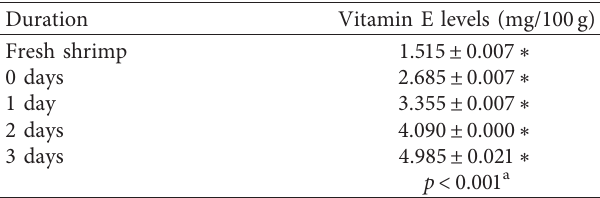
Table 3: Results of the vitamin E level (mg/dl) of fermented shrimp sausages at different fermentation